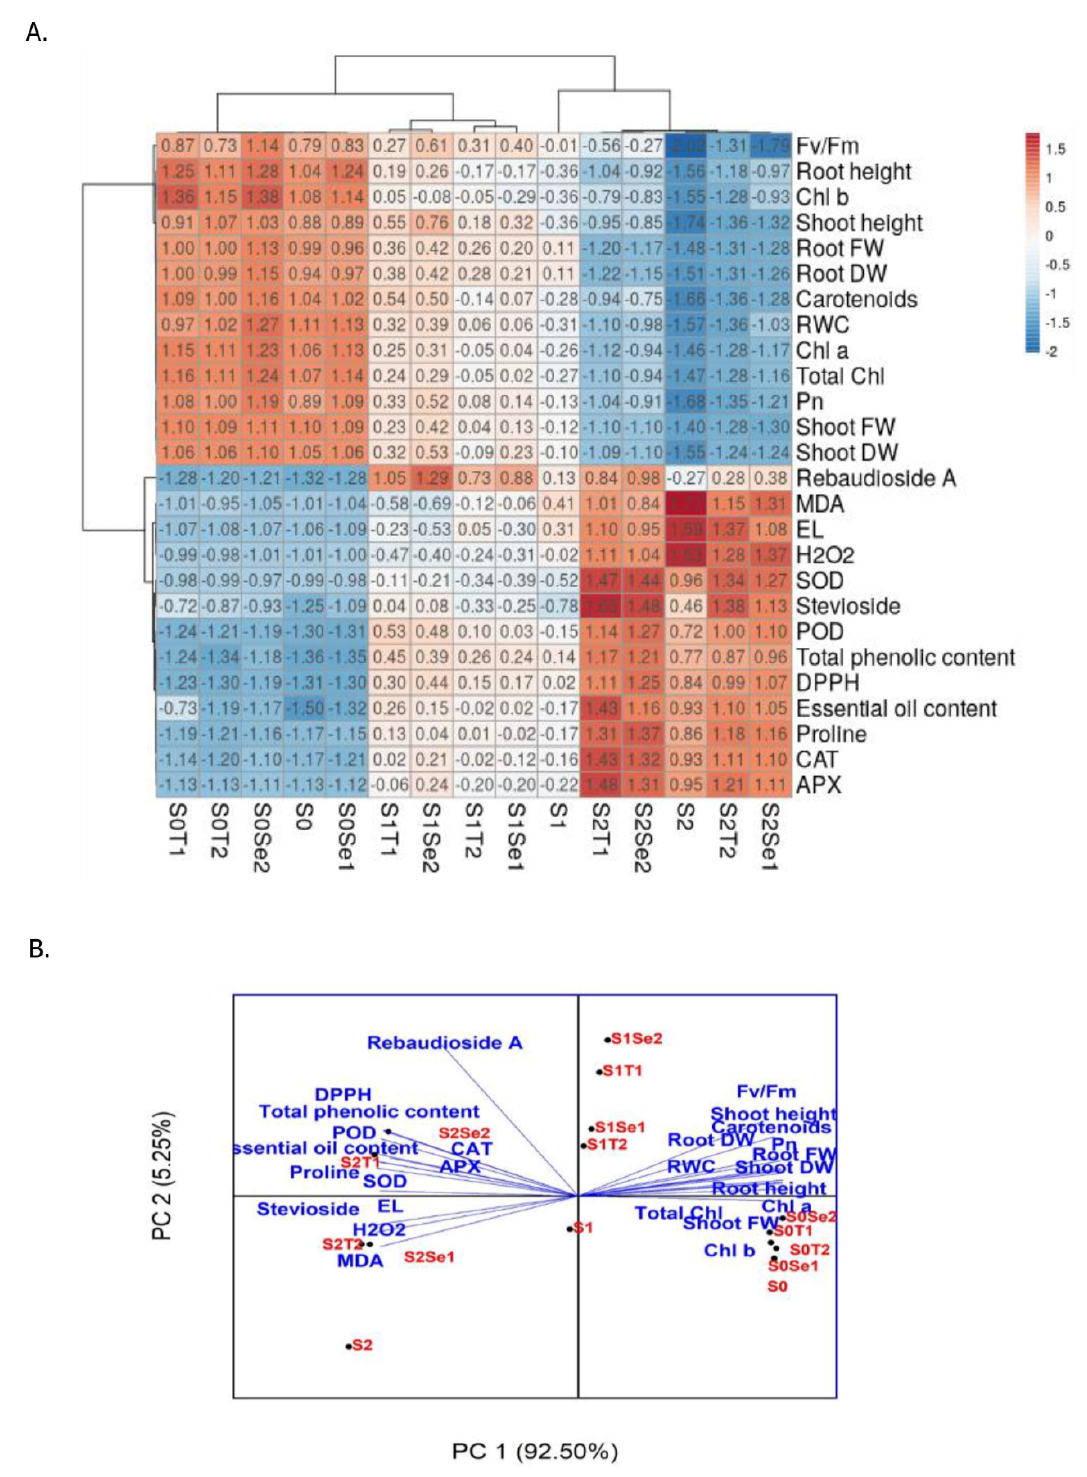
Figure 6. Heat map corresponding to the dependent and independent variables along with the treatments ( A ) and the principal component analysis regarding the observations ( B ) of salinity and TiO 2 and Cs–Se nanoparticle applications on the examined traits in Stevia rebaudiana Bertoni (S 0 : 0 mM NaCl; S 0 Se 1 : 0 mM NaCl, 10 mg L − 1 Cs–Se NPs; S 0 Se 2 : 0 mM NaCl, 20 mg L − 1 Cs–Se NPs; S 0 T 1 : 0 mM NaCl, 100 mg L − 1 TiO 2 NPs; S 0 T 2 : 0 mM NaCl, 200 mg L − 1 TiO 2 NPs; S 1 : 50 mM NaCl; S 1 Se 1 : 50